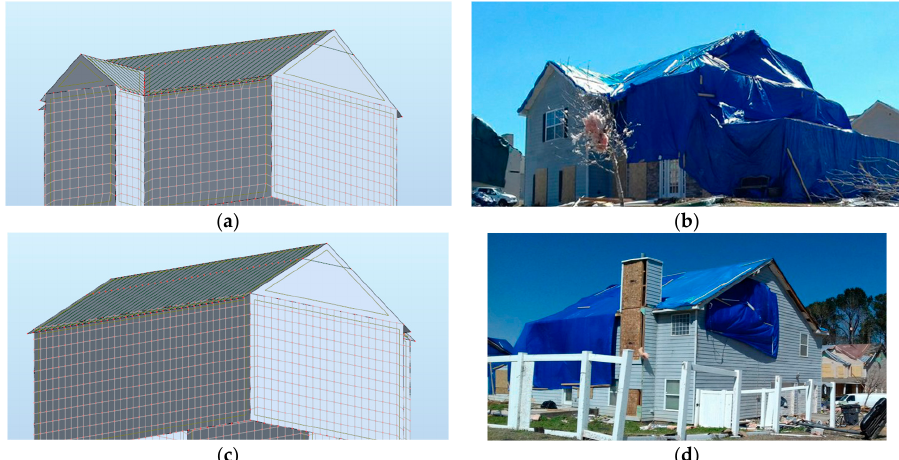
Figure 7. Comparison of the model and building after damage, ( a )—computer model, view from the windward side, ( b )—structure after damage, view from the windward side, ( c ) computer model, view from the leeward side ( d ) structure after damage, view from the leeward side. [Foto made by authors of the article].